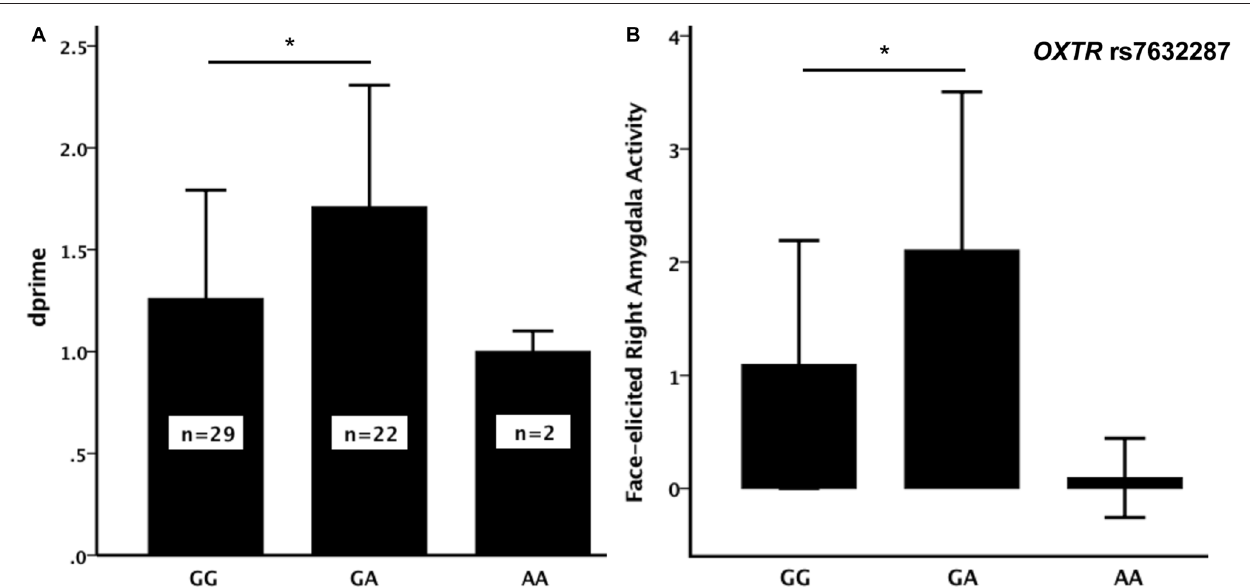
FIGURE 1 | (A) Face recognition performance (dprime, mean ± SD) and (B) face-elicited right amygdala activity (mean (over participants) average parameter estimates for the amygdala as defined by the WFU-Pickatlas ± SD) for the three genotypes of the oxytocin receptor (OXTR) rs7632287 single nucleotide polymorphism (SNP). There was a significant difference ( ∗ ) in dprime ( p = 0.007, t 49 = 2.84) and face-elicited right amygdala activity ( p = 0.006, t 49 = 2.90) between GG and GA